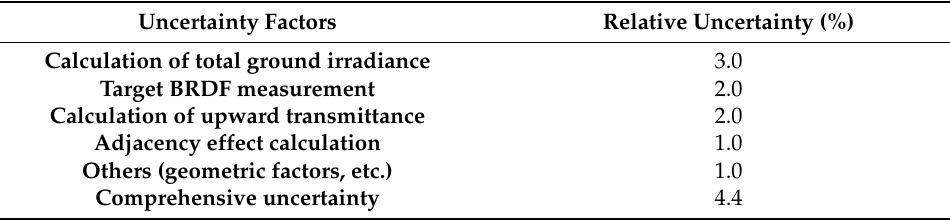
Table 4. Uncertainty analysis for the vicarious calibration using RCRII model. Uncertainty Factors Relative Uncertainty (%) Calculation of total ground irradiance 3.0 Target BRDF measurement 2.0 Calculation of upward transmittance Adjacency effect calculation Others (geometric factors, etc.) Comprehensive